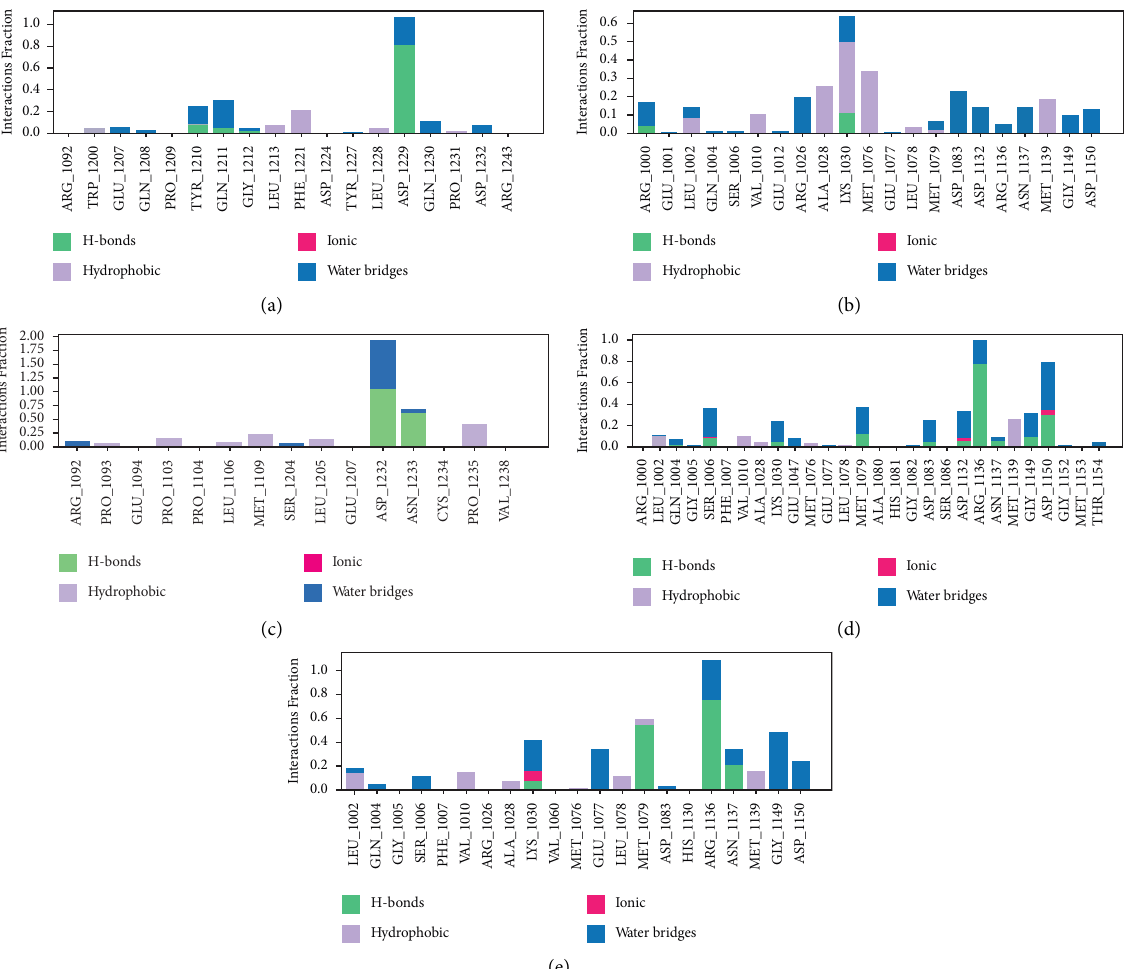
Figure 8: Te interactions between proteins and ligands identifed during the 100ns simulation are shown in the stacked bar charts. In this section, the interactions of the chosen ligand molecules are demonstrated. Figures (a)–(e) in the image above represented, respectively, the intermolecular fractions for the compounds CID 1886, CID 122801, CID 101306757, CID 102090424, and CID